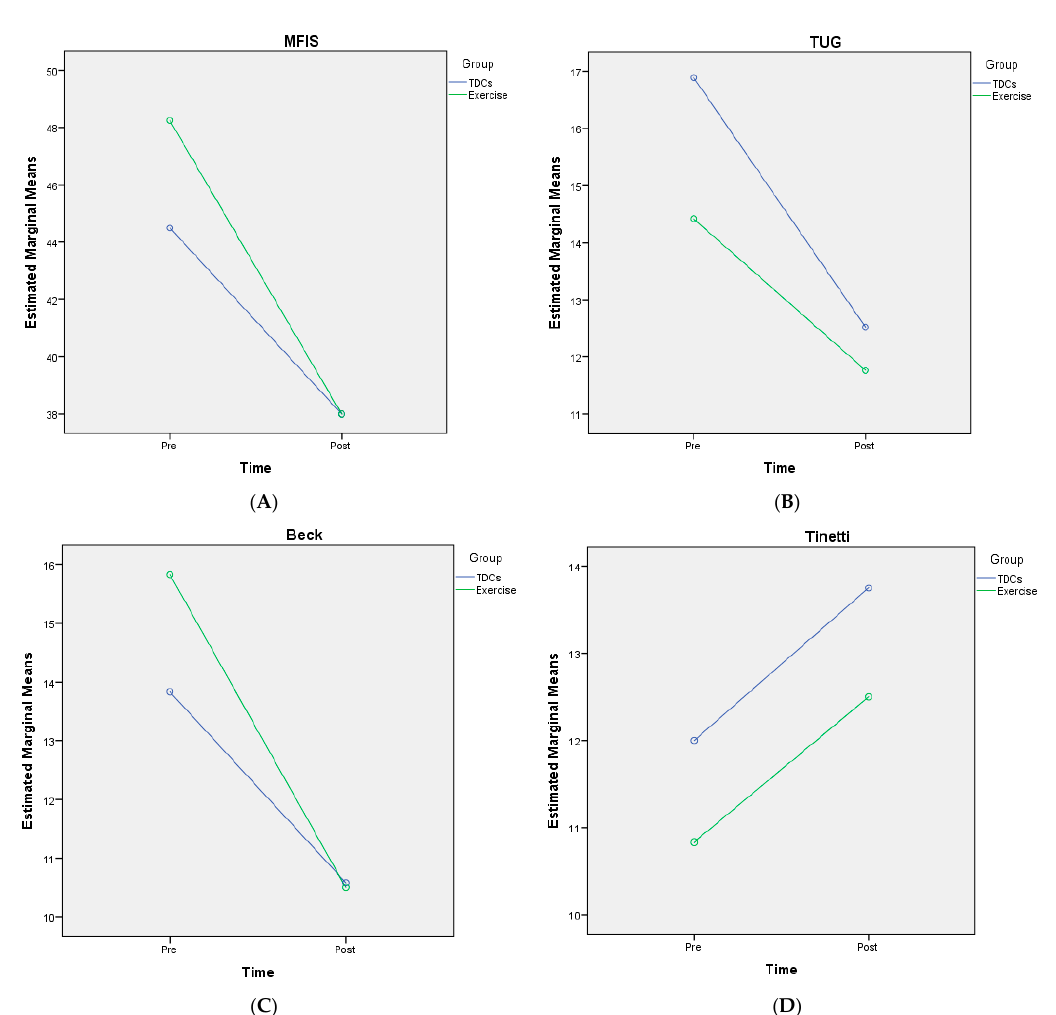
Figure 2. Two-way mixed-measures analysis of variance: ( A ) fatigue questionnaire (MFIS); ( B ) func- tional mobility test (TUG); ( C ) Beck Depression Questionnaire; ( D ) balance test (Tinetti); mean scores and effectiveness for tDCS and exercise groups before treatment (pre) and after treatment